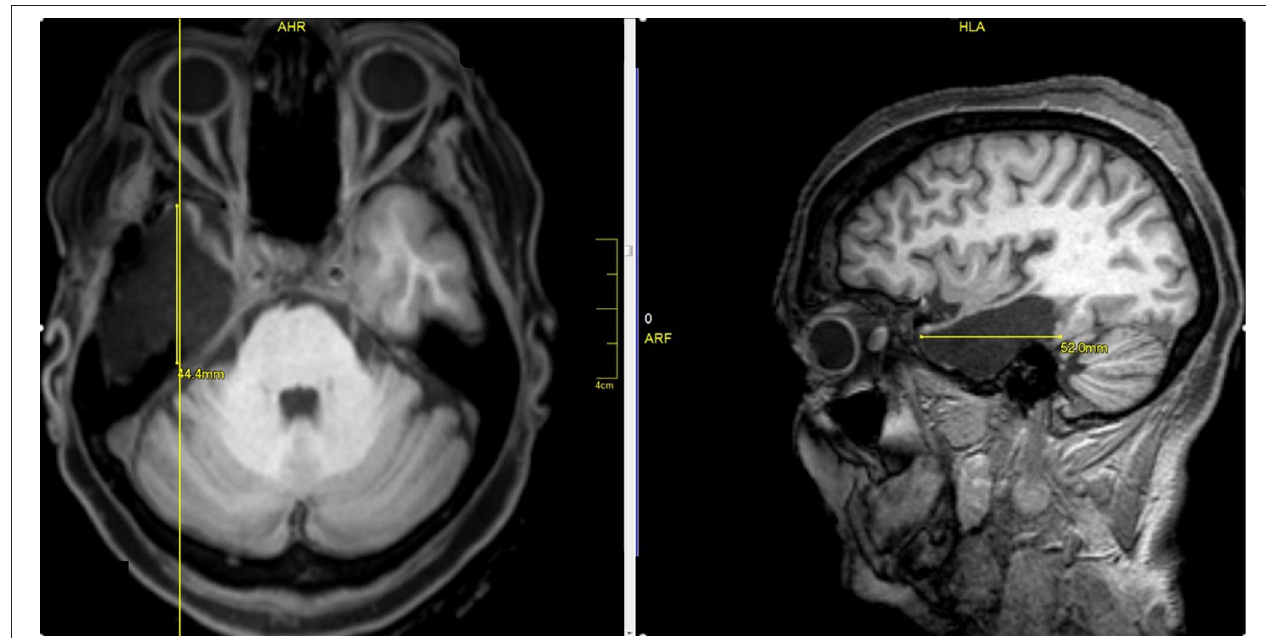
FIGURE 1 | Right standard anteromesial temporal lobectomy with amygdalohippocampectomy.